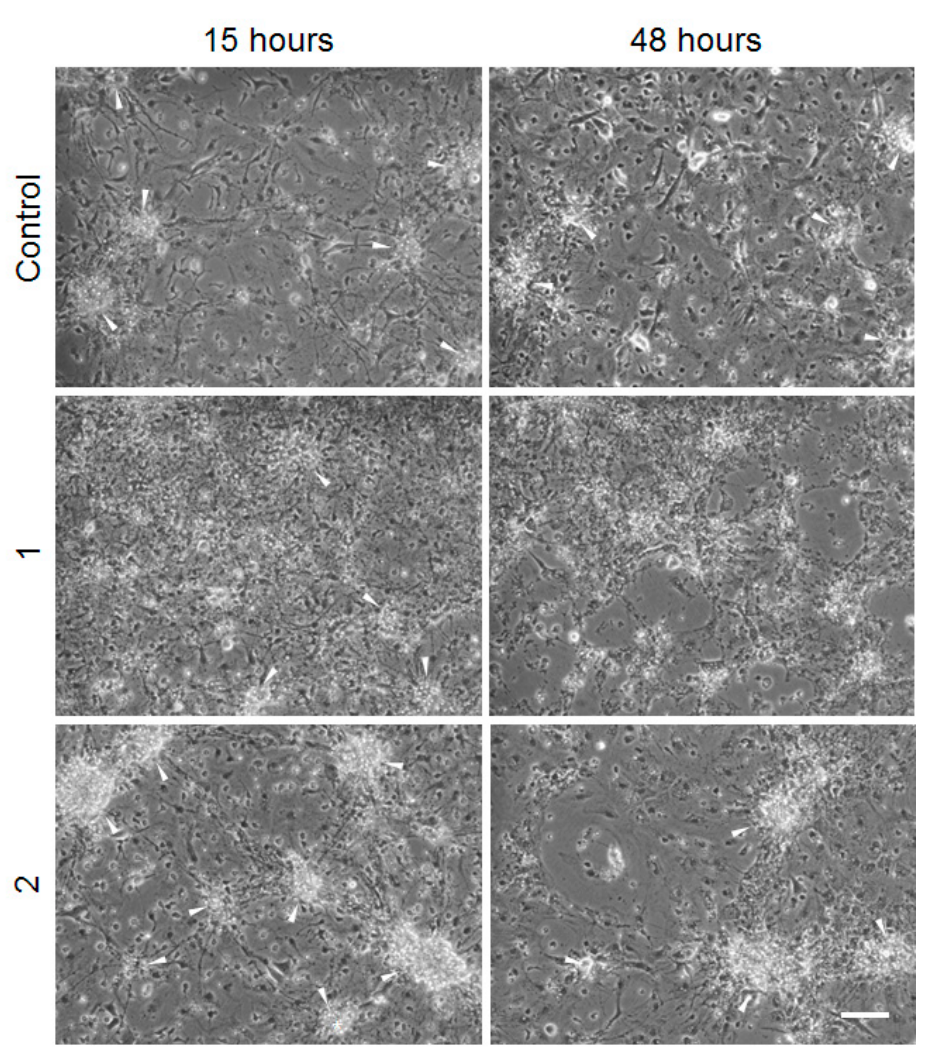
Figure 8. Co-culture of neuronal cells and U87 glioma cells in the absence or presence of 1 µM of 1 or 2 . The neuronal aggregates are marked by arrowheads. Scale bar: 100 µm.